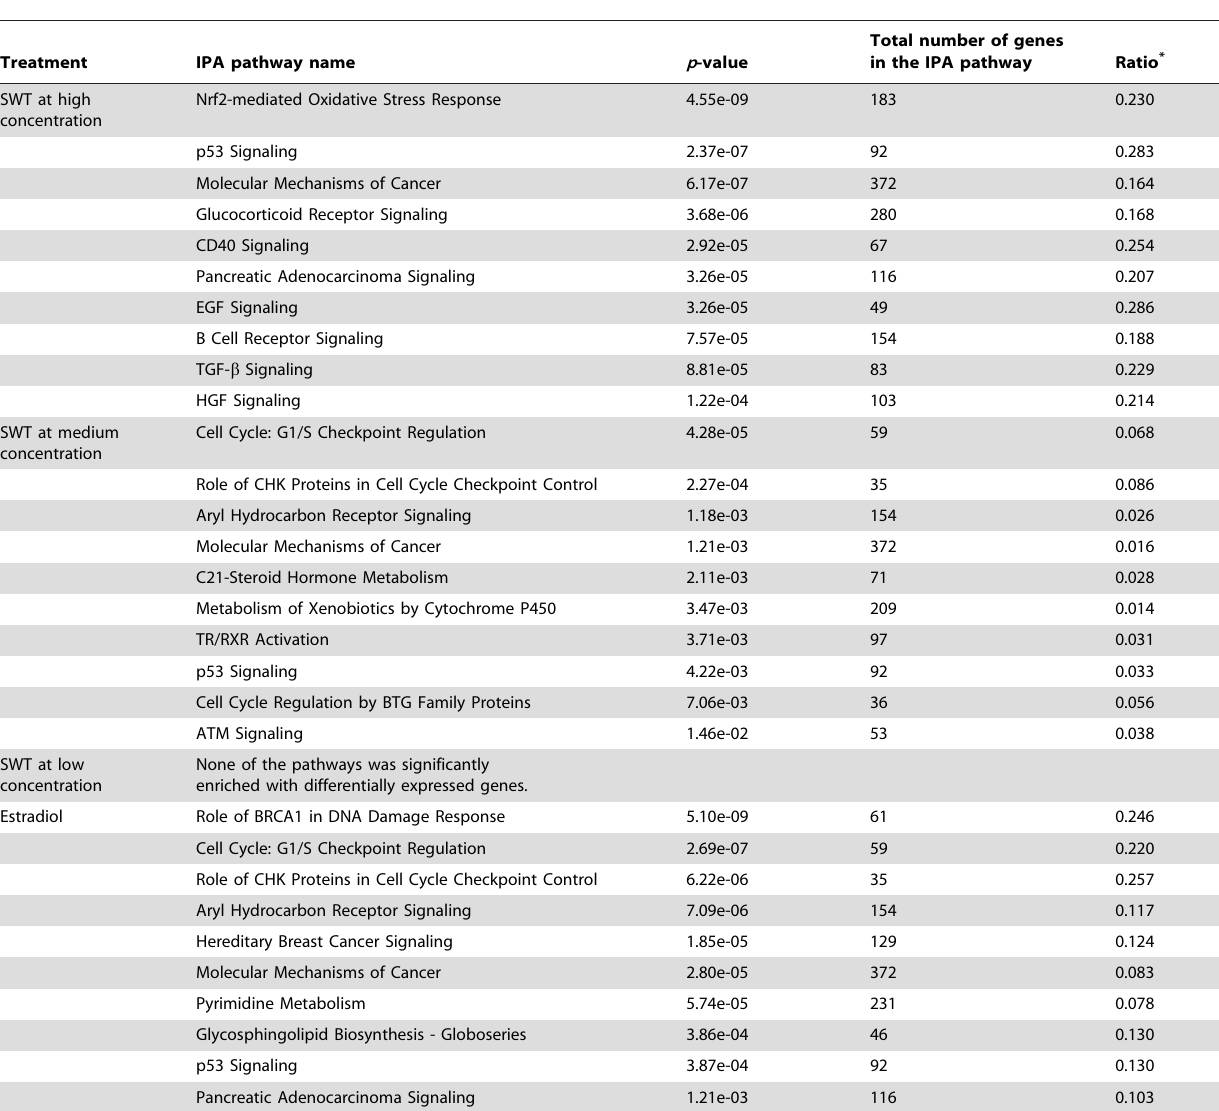
Table 2. Top IPA pathways enriched with differentially expressed genes and their corresponding Fisher’s exact test p values.